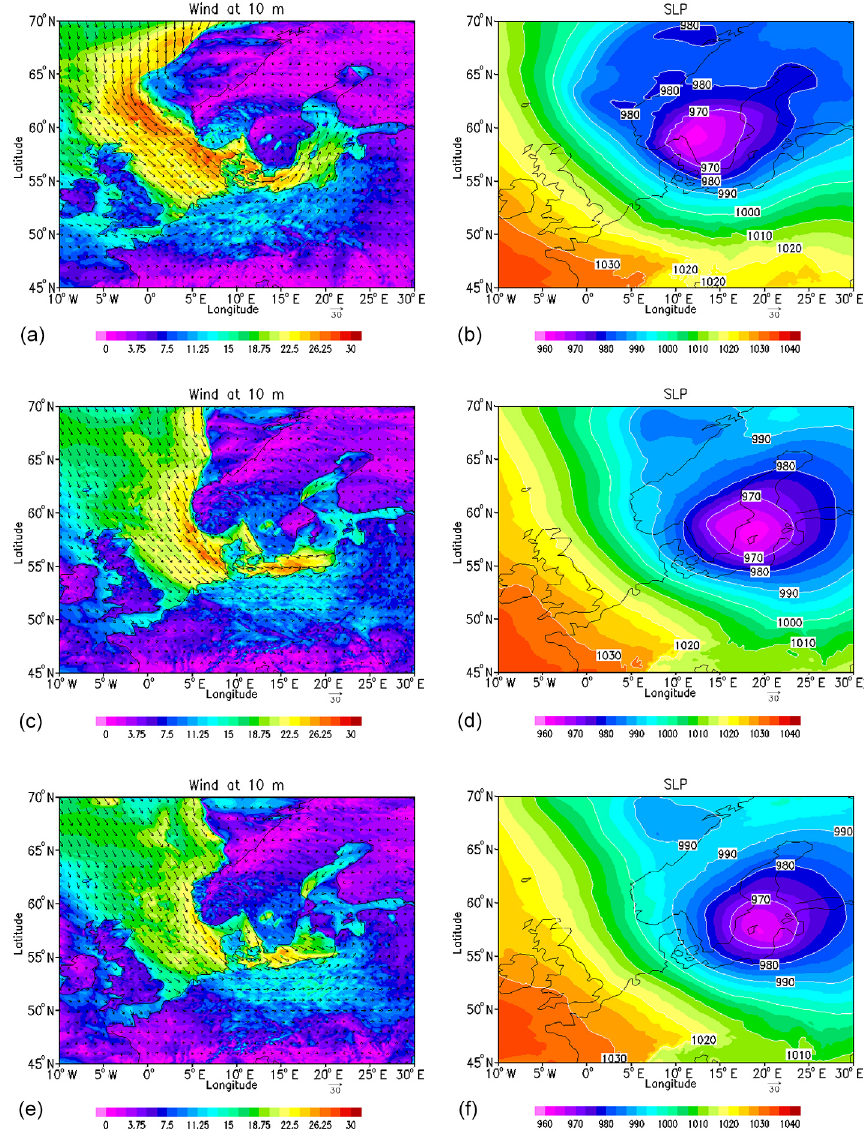
Figure 3. Meteorological situation during Xaver: (a) DWD 10m wind magnitude [ms − 1 ] (in colour) and wind direction (arrows) on 5 De- cember 2013 at 18:00UTC, (b) Sea level pressure [hPa] on 5 December 2013 at 18:00UTC, (c) same as (a) but on 6 December 2013 at 03:00UTC, (d) same as (b) but on 6 December 2013 at 03:00UTC, (e) same as (a) but on 6 December 2013 at 07:00UTC, (f) same as (b) but on 6 December 2013 at